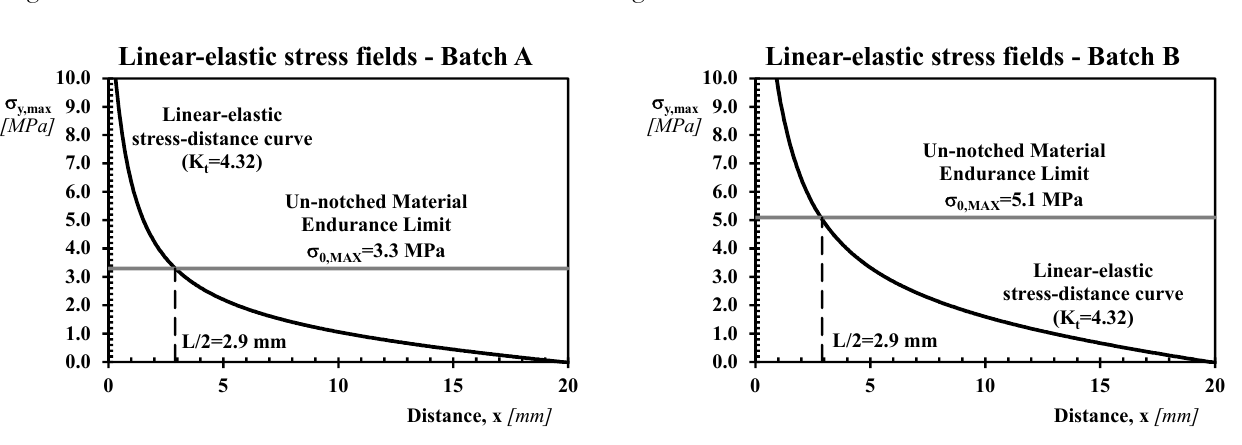
Figure 3: Critical distance L determined for Batch A and Batch B according to the PM.